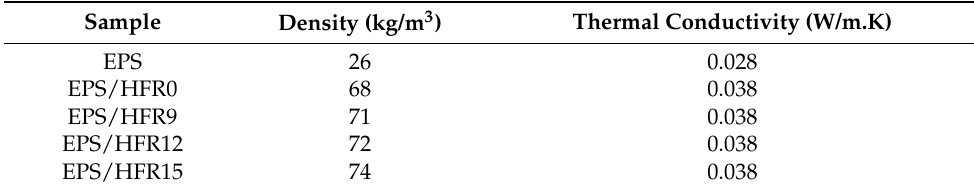
Table 3. Physical properties of the neat EPS and flame-retardant-based EPS foam.